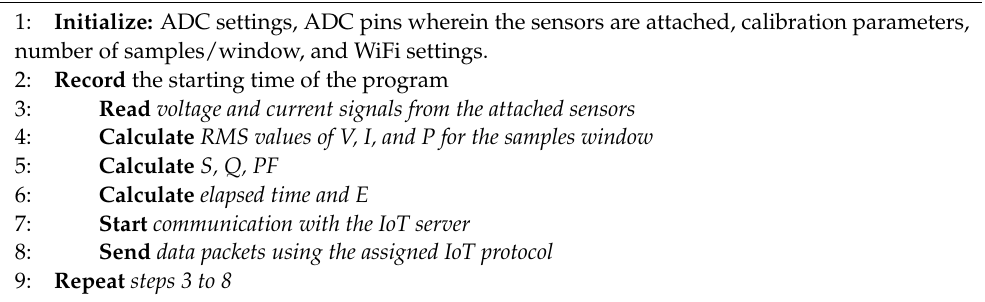
Algorithm 1 The procedure of data collection, processing, and